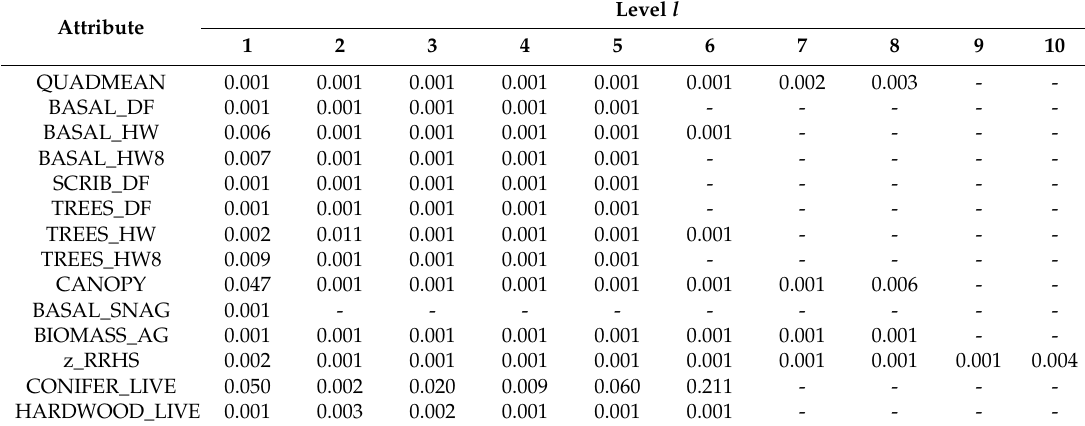
Table 3. p -Values for attributes at level l for kernel NCs compared to forest NCs excluding kernels.